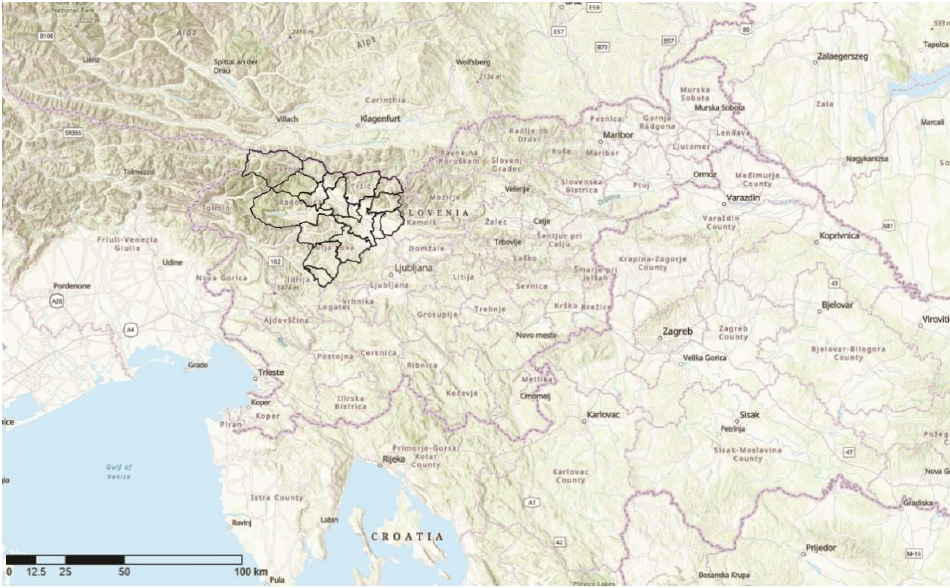
Figure 1. The studied area of the Gorenjska region.